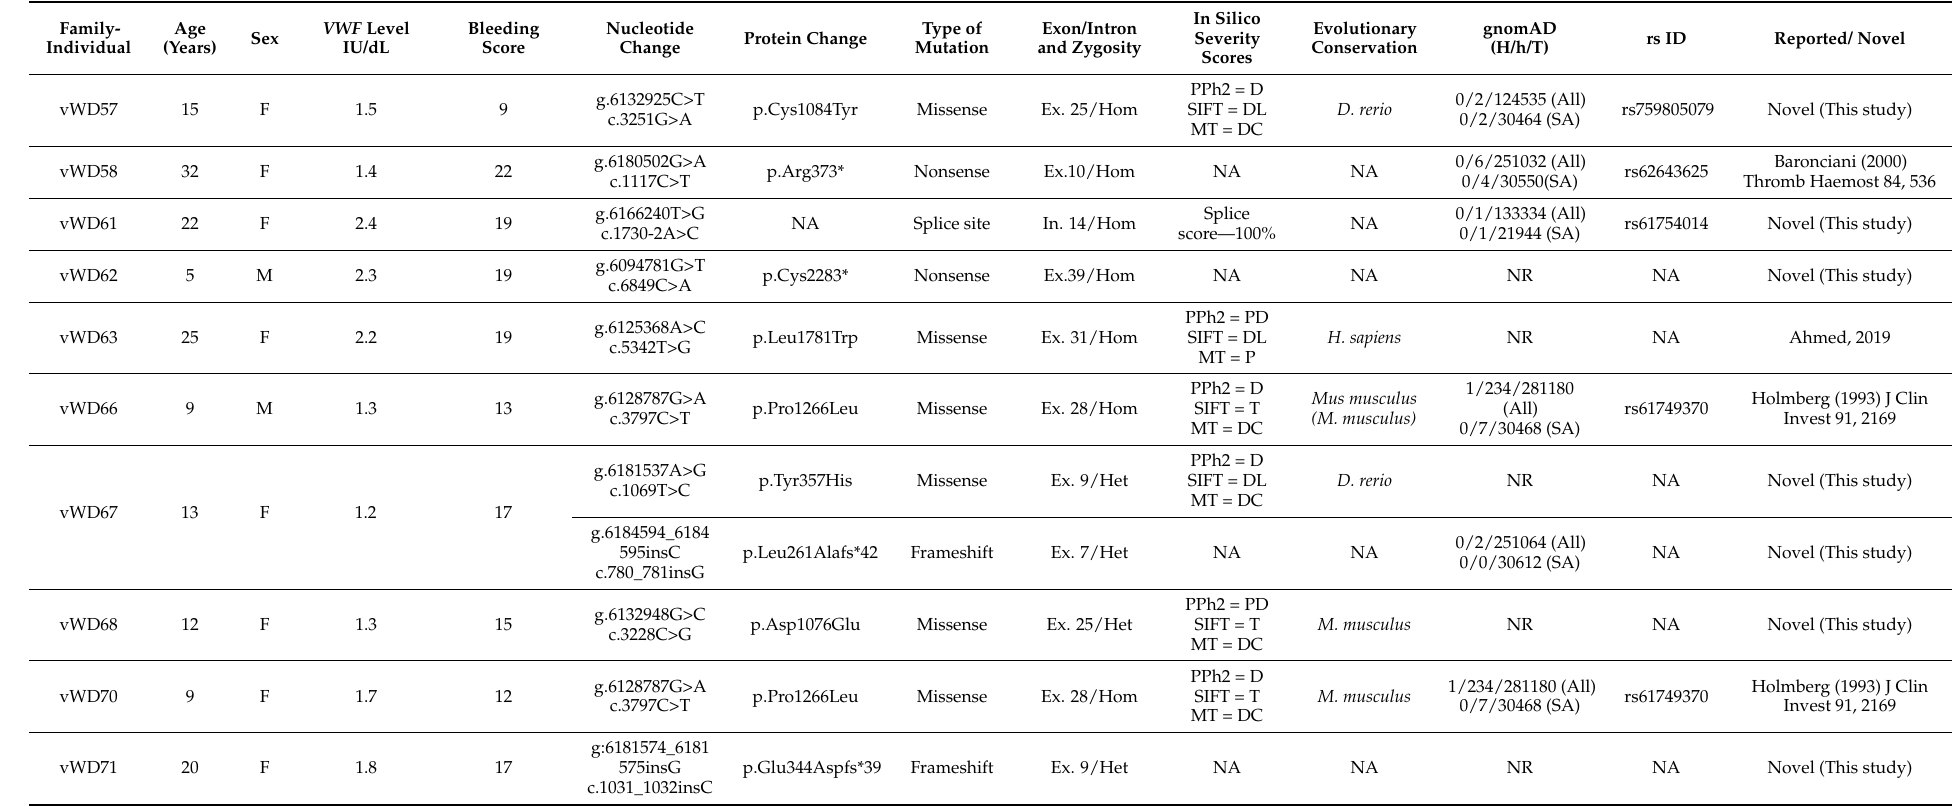
Table 1: All, gnomAD frequency data for all populations; D, probably damaging; DC, disease causing; DL, deleterious; Ex, exon; F, female; gnomAD v2.1.1, summary of data within Genome Aggregation database; H, homozygotes in gnomAD; h, heterozygous alleles in gnomAD; In, intron; M, male; NA, not available; NR, not reported; SIFT, Sorting intolerant